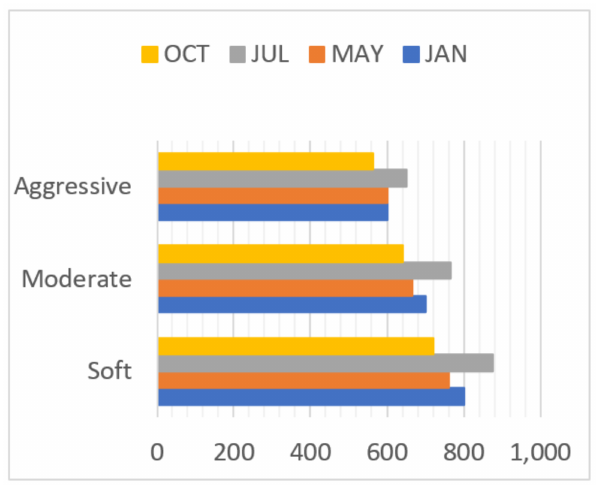
Figure 7. Monthly Cap Values in